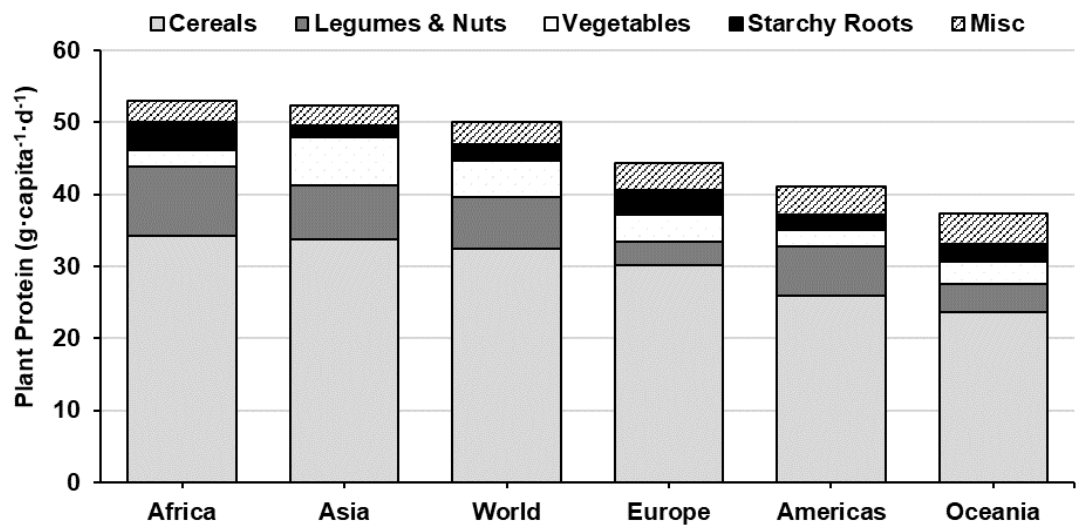
Figure2. World andcontinentalplant protein consumptionby source (g · capita − 1 · d − 1 ) [9]. Misc.includes Figure 2. World and continental plant protein consumption by source (g·capita −1 ·d −1 ) [9]. Misc. includes protein from fruit, seeds, spices, stimulants and aquatic protein from fruit, seeds, spices, stimulants and aquatic plants.